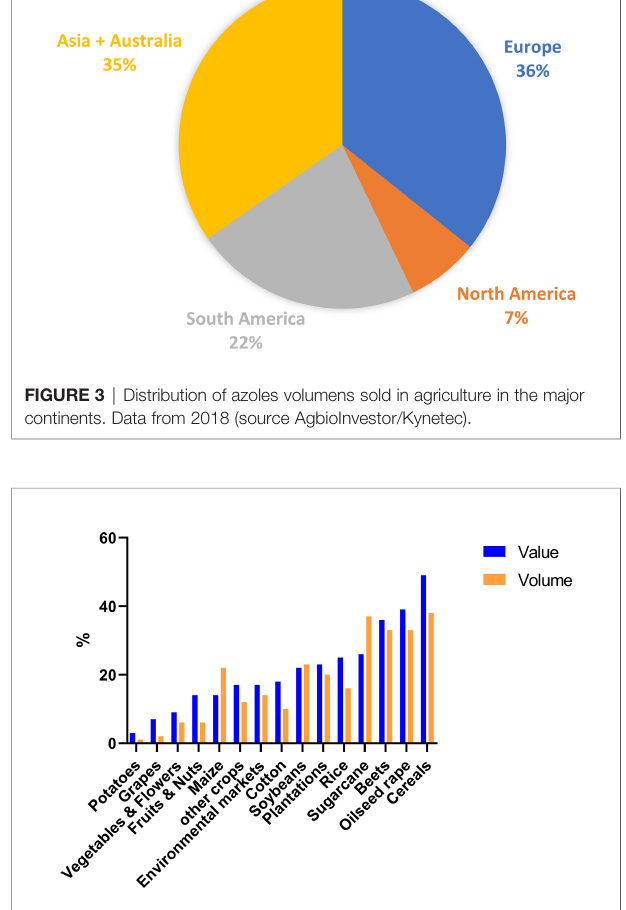
FIGURE 2 | Importance of azoles in the overall global fungicide market. Azoles share (%) of global fungicide marked shown in value and volume during 24 years (source: Bayer Internal Source).